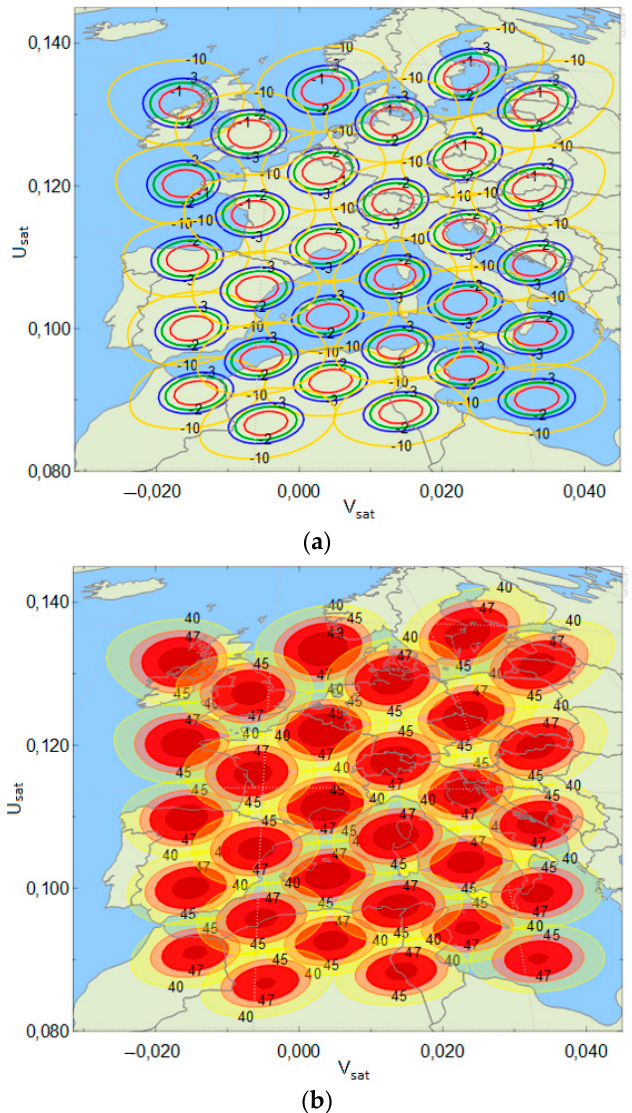
Figure 12. Multi-spot coverage produced by the designed DRAA after the projection over the Earth’s surface: ( a ) relative contour patterns and ( b ) absolute gain levels (in dBi) at 20 GHz.